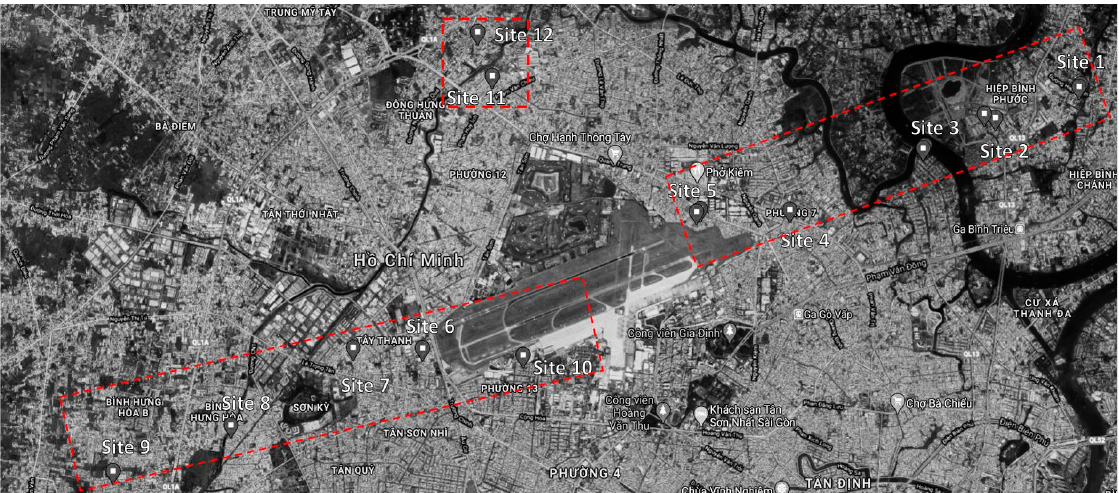
Figure 1. Map of survey sites indicating the location of the surveyed residential areas.